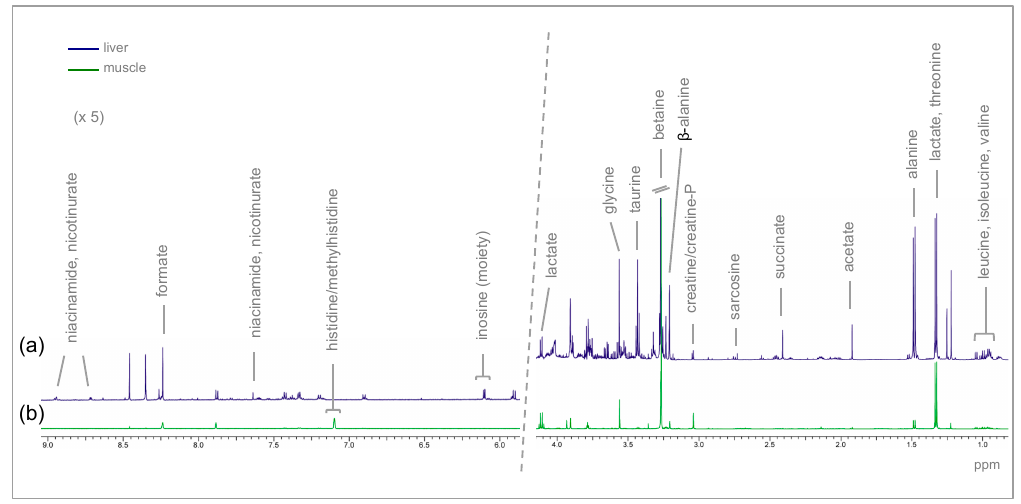
Figure 1. Representative NMR spectra of rainbow trout: ( a ) CPMG (Carr-Purcell-Meiboom-Gill) spectrum of the aqueous fraction of liver; and ( b ) 1D 1 H spectrum of the aqueous fraction of muscle, with the assignments of the main identified metabolites.